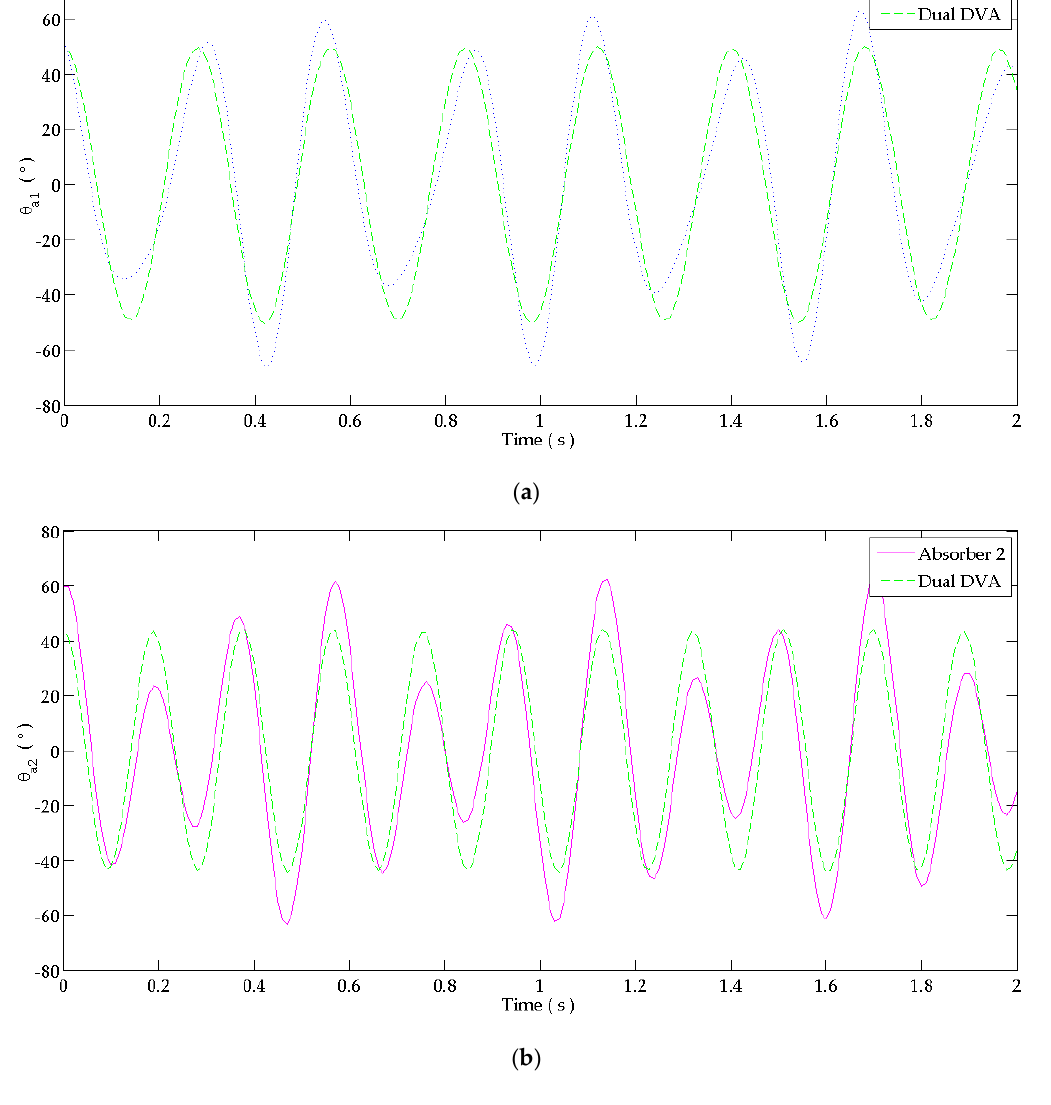
Figure 10. Response in time domain at: ( a ) “absorber 1”; ( b ) “absorber 2” joints. The fluctuations at the joints of the absorbers when attached alone and together as a ”dual DVA” for 𝑐 𝑎 = 0.0002 𝑘 𝑎 .